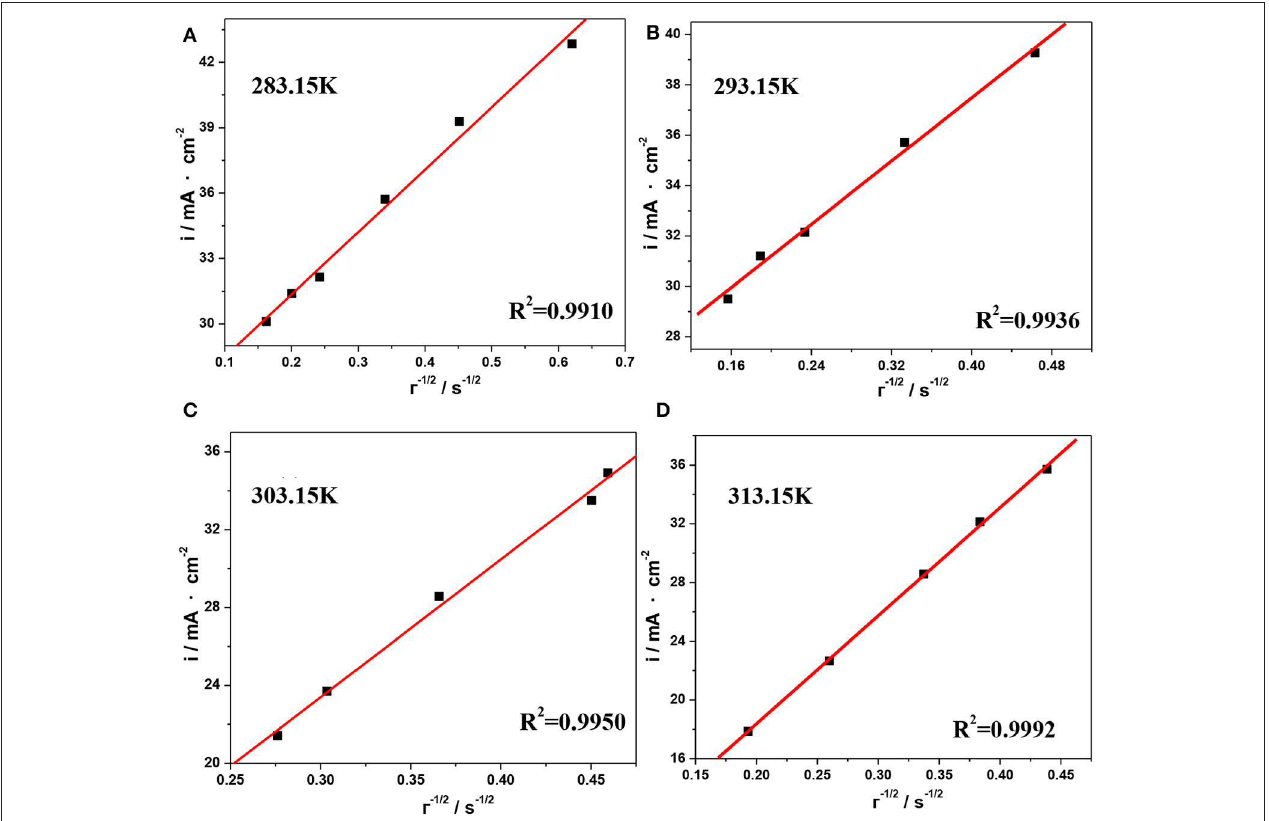
FIGURE 10 | Current density as a function of the reciprocal of the square root of the transition time for the reduction reaction of V(III) at different temperatures, (A) 283.15 K, (B) 293.15 K, (C) 303.15 K, and (D) 313.15 K.